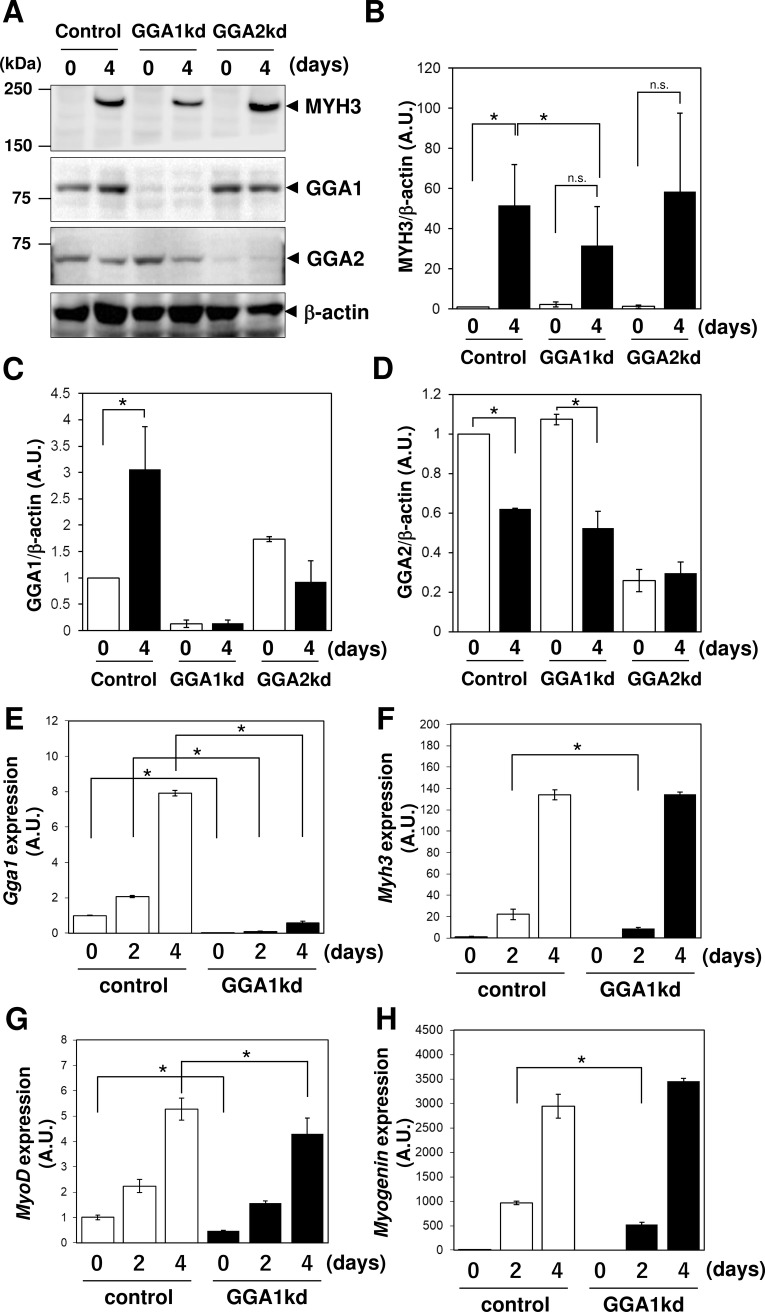
Gga1 knockdown caused a defect in the expression of MYH3.(A) Golgi associated, gamma adaptin ear containing, ARF binding protein (GGA)1, GGA2, and myosin heavy chain 3 (MYH3) expression in control, Gga1kd and Gga2kd cells before (day 0) and after (day 4) myogenic differentiation were examined by immunoblotting. b-actin was used as a loading control. (B) Expression of myogenic genes (Myod (myosin D), Myog (myogenin), and Myh3) and Gga1 gene at the differentiation periods of 0, 2 and 4 days in the control and Gga1kd cells was analyzed by quantitative real-time PCR (qPCR). Actb (b-actin) was used as the endogenous control. Error bars indicate SD (n = 3). *. P < 0.05 by Welch’s t-test.